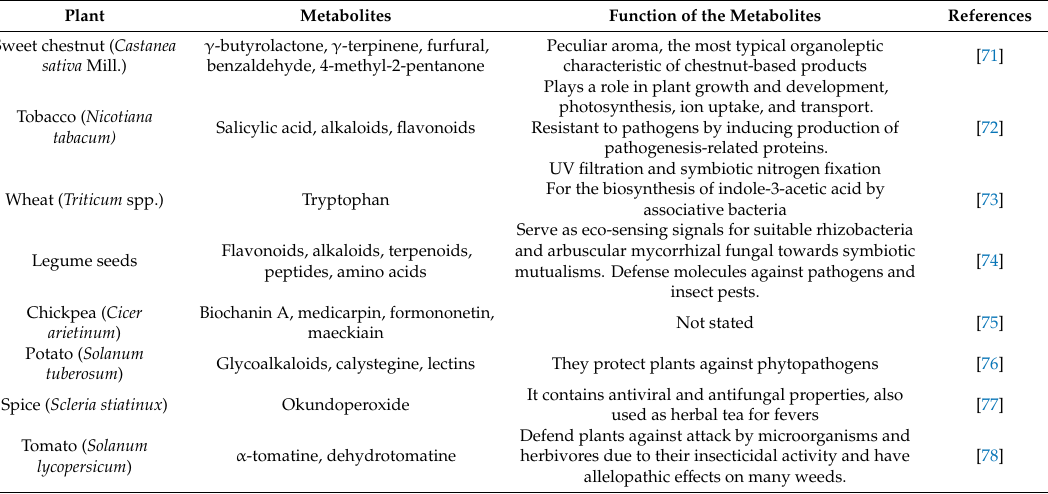
Table 3. Plant roots secrete a range of metabolites into the